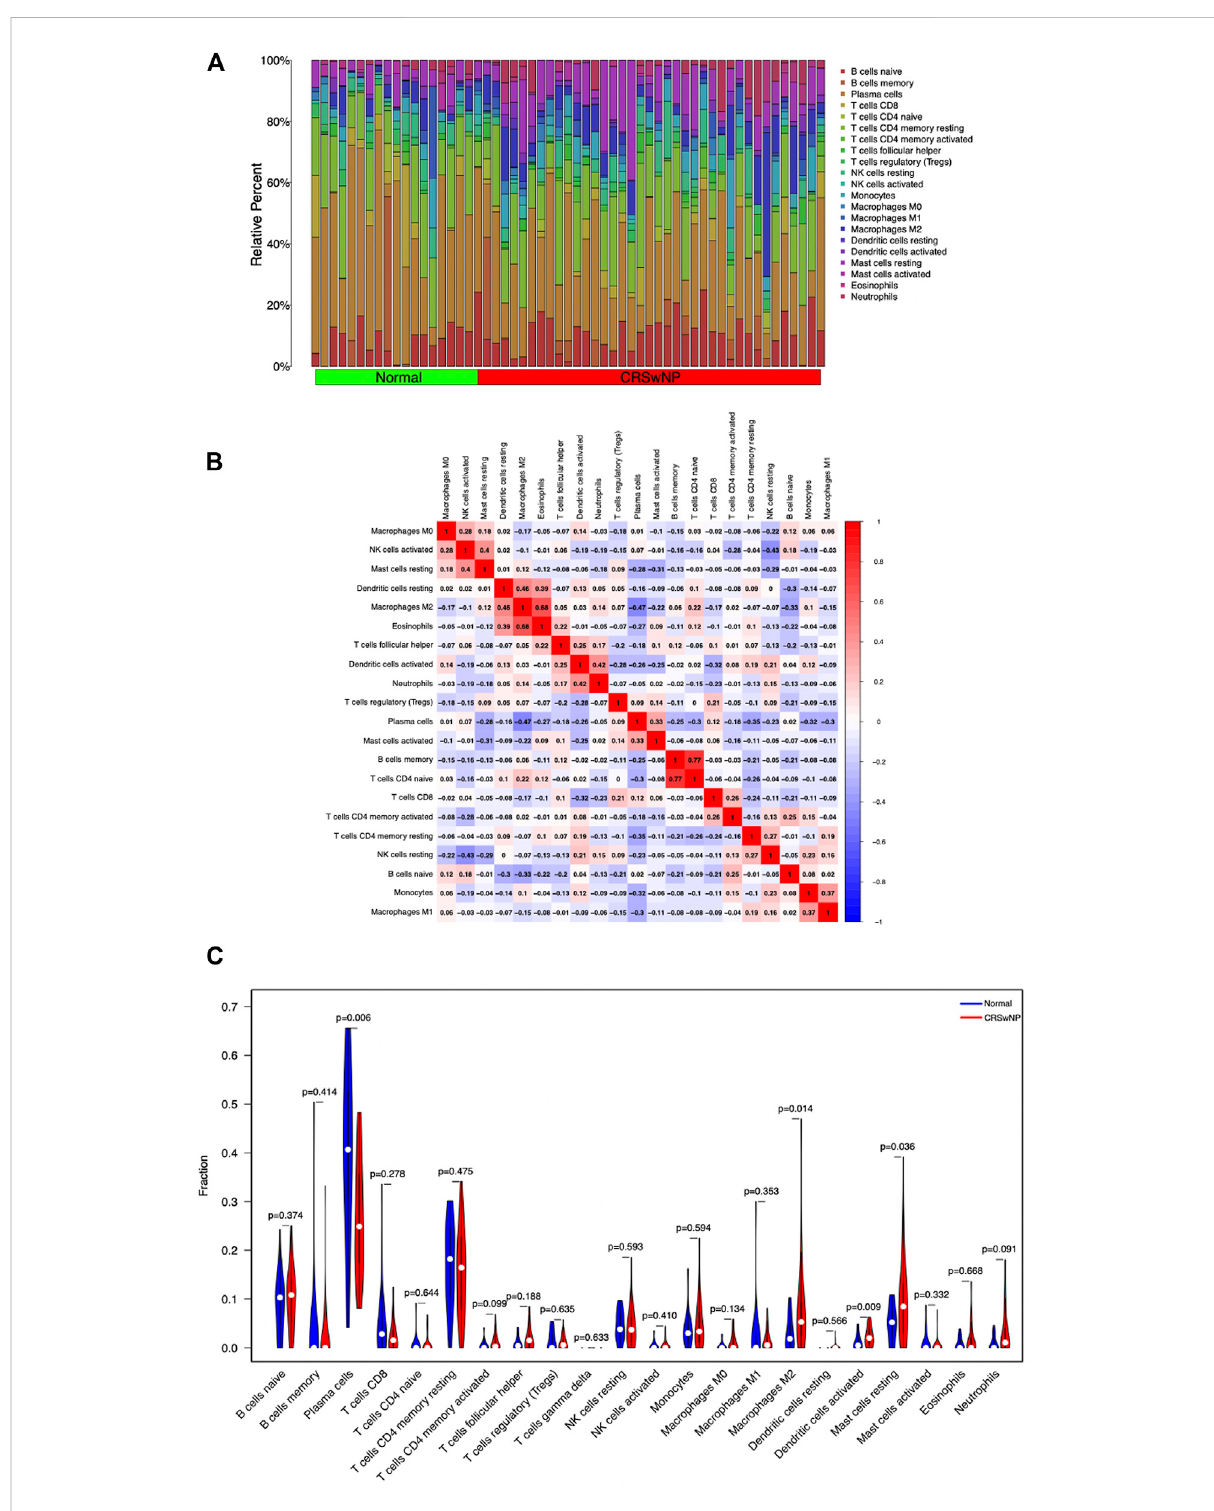
FIGURE 7 Differences and correlation of immune cell in fi ltration between the CRSwNP group and normal group. (A) Summary of immune in fi ltration in 22 immune cell subpopulations from 57 samples. (B) Correlation matrix of 22 immune cell in fi ltration in 57 samples. (C) Violin plot of differential expression of 22 in fi ltrating immune cells. Abscissa: immune cell types; ordinate: relative immune cell content; red: CRSwNP group; blue: Normal